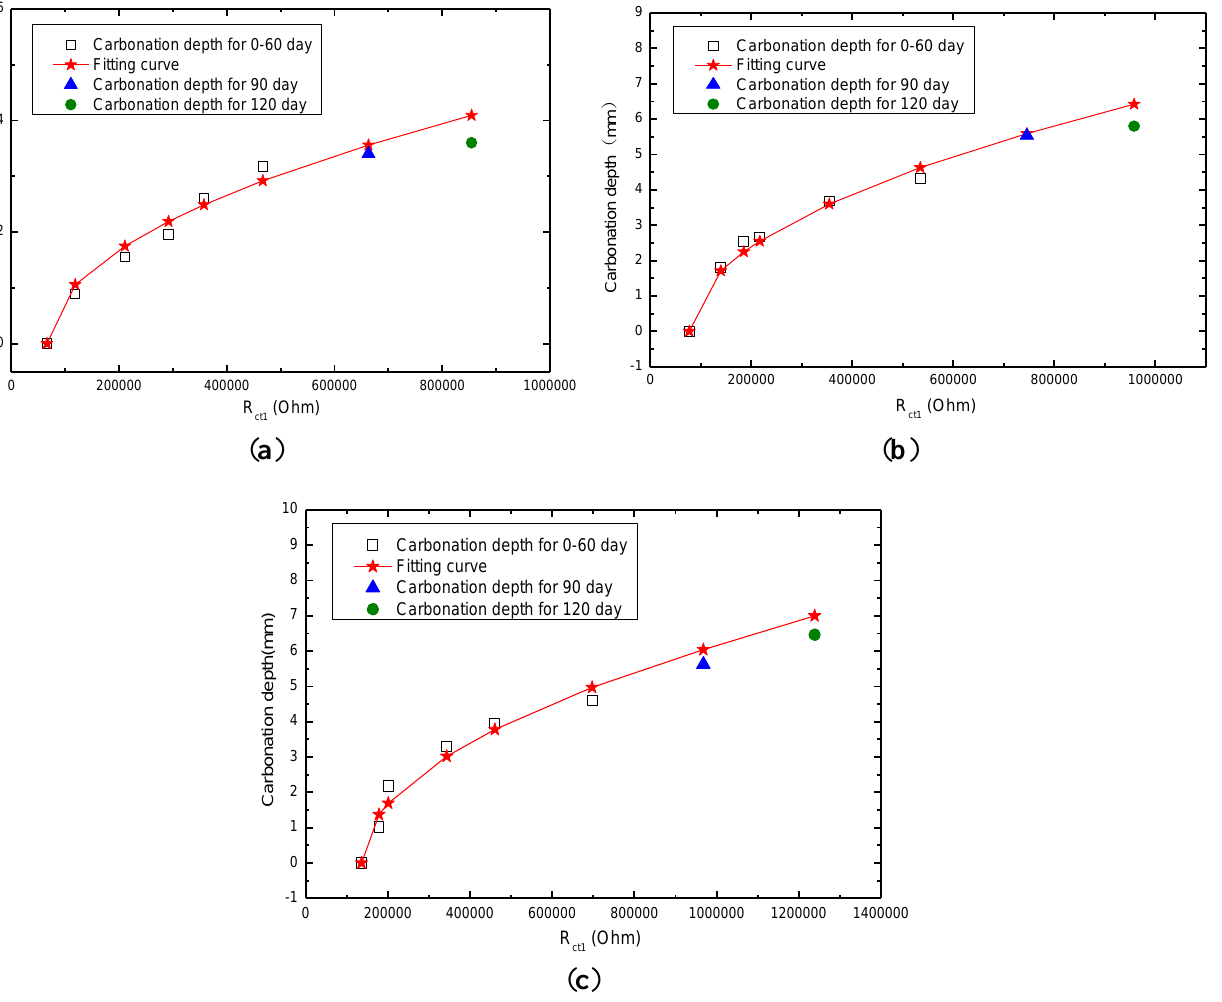
Figure 9. Comparison of the experimental results with fitting results based on for the mortar: ( a ) mortar with 1:2 cement/sand ratio; ( b ) mortar with 1:3 cement/sand ratio; ( c ) mortar with 1:4 cement/sand ratio.